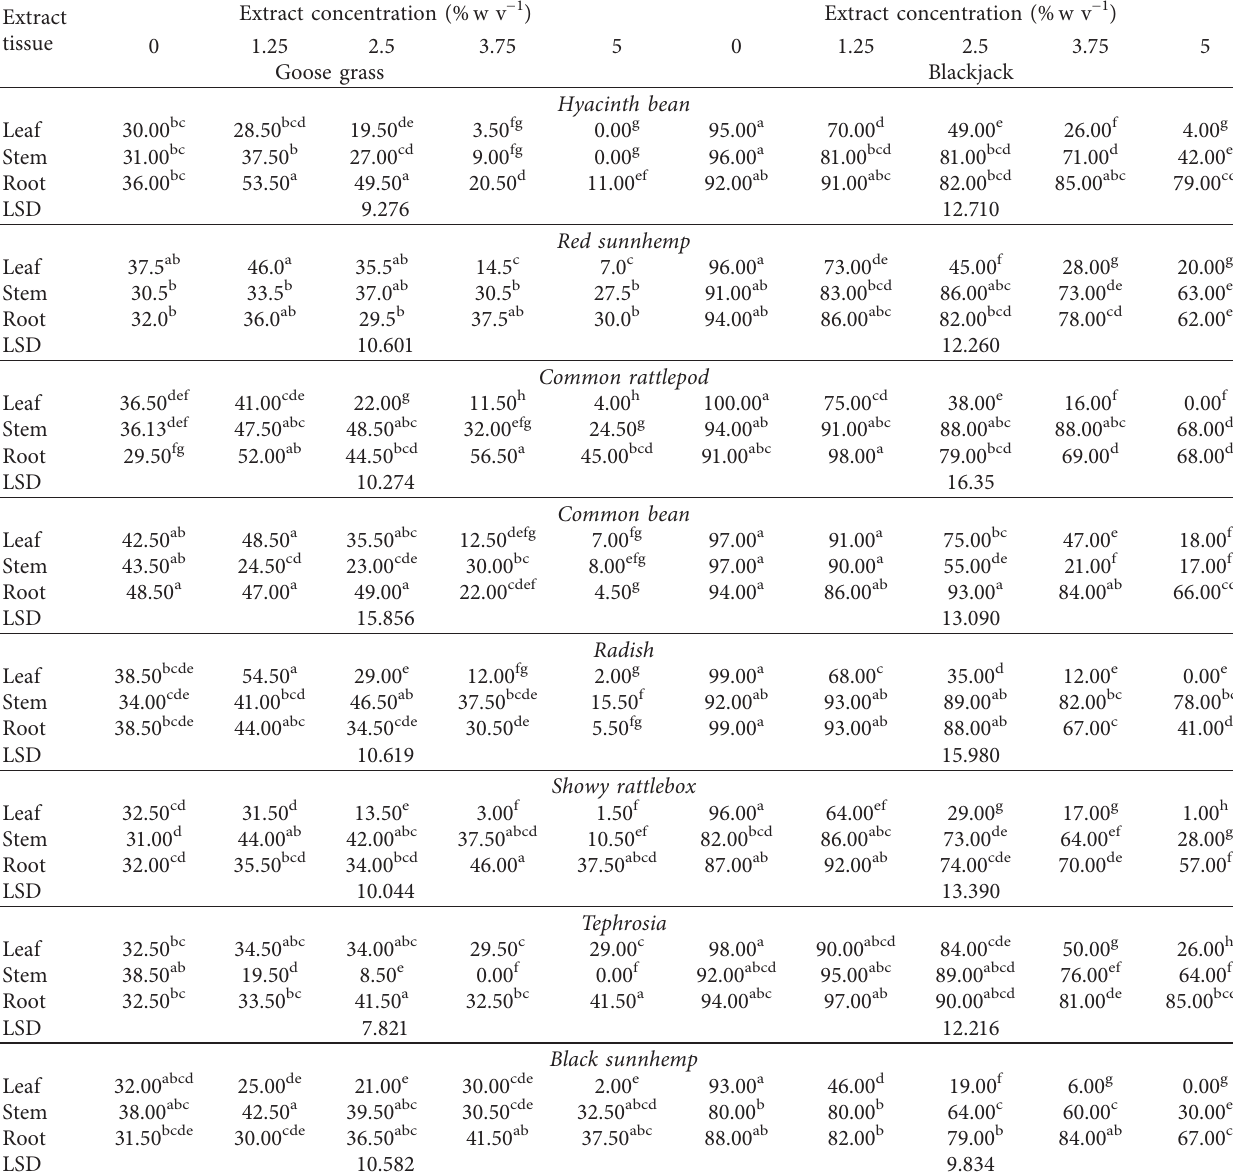
Table 3: Effect of aqueous extracts of eight green manure cover crops on germination percentage of goose grass and blackjack.